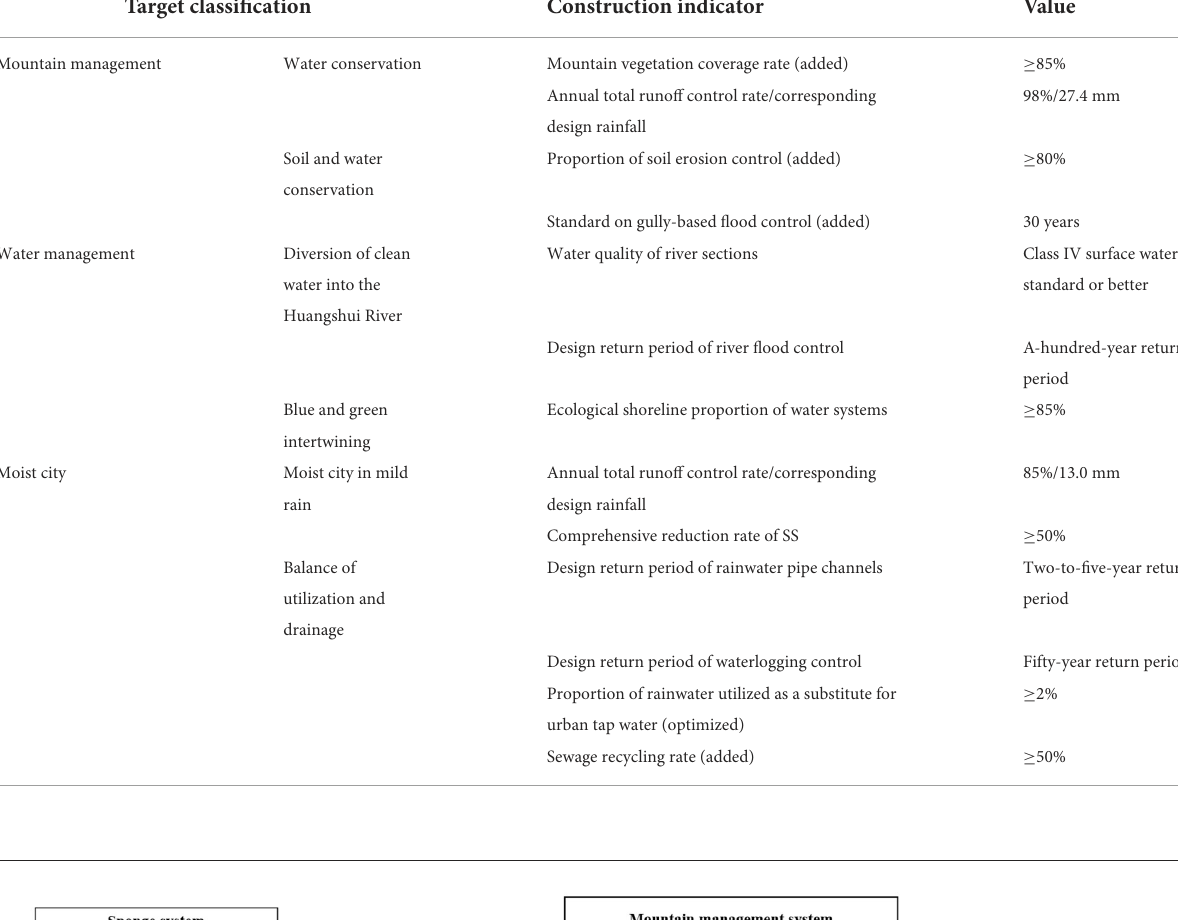
TABLE 3 Indicator system for the sponge city construction based on the “mountain management–water management–moist city” framework.